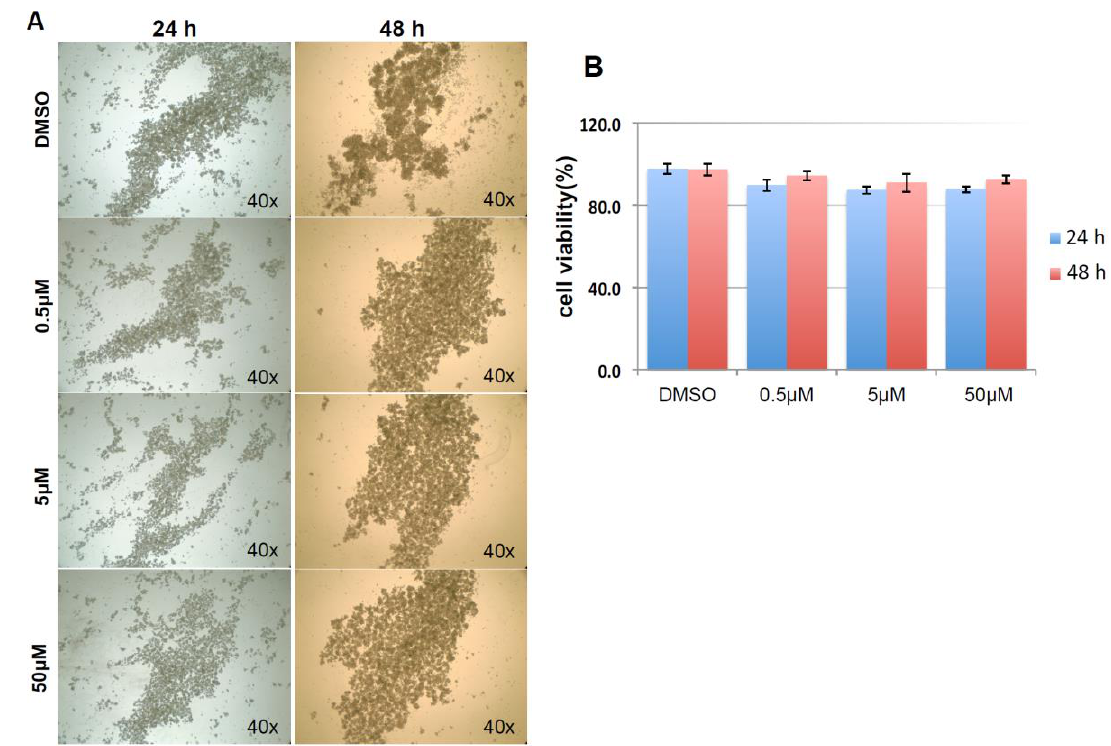
Figure 10. Demecolcine treatments on MDA-MB-231 in suspension culture. ( A ) Morphologies for MDA-MB-231 treated with 0.5, 5, 50 µM of Demecolcine for 24 and 48 h. There was not much difference in morphologies in terms of cell aggregation between control DMSO treated cells and the cell treated with different concentration of Demecolcine; ( B ) cell viability, both cells treated with DMSO and the cells treated with different concentration of Demecolcine show high cells viability in 24 and 48 h after the treatment with no significant difference.